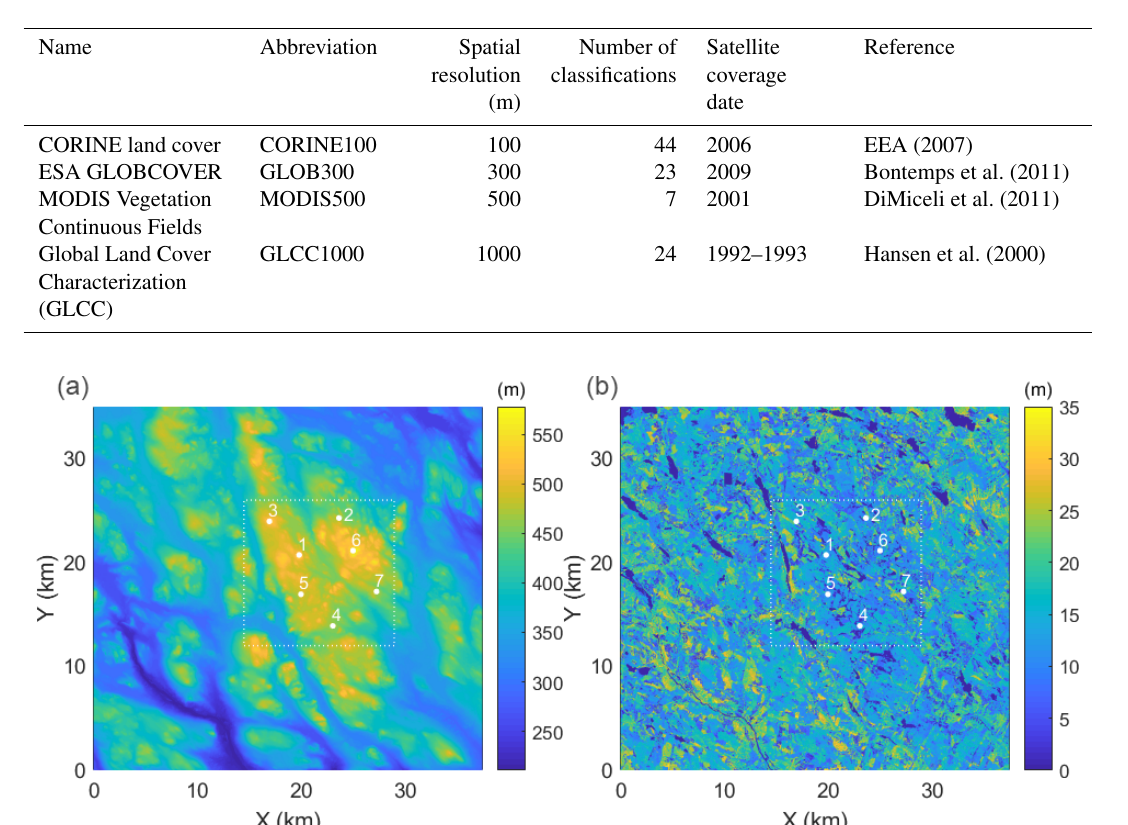
is on the forest parameters, but the terrain height will